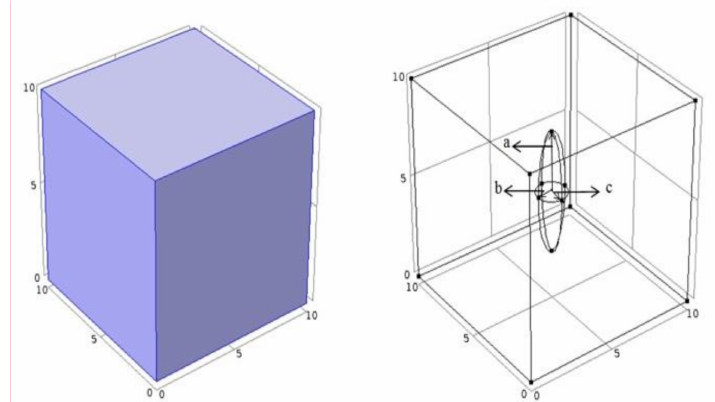
Figure 4. A cubic cell of 10 × 10 × 10 µ m with one water void.